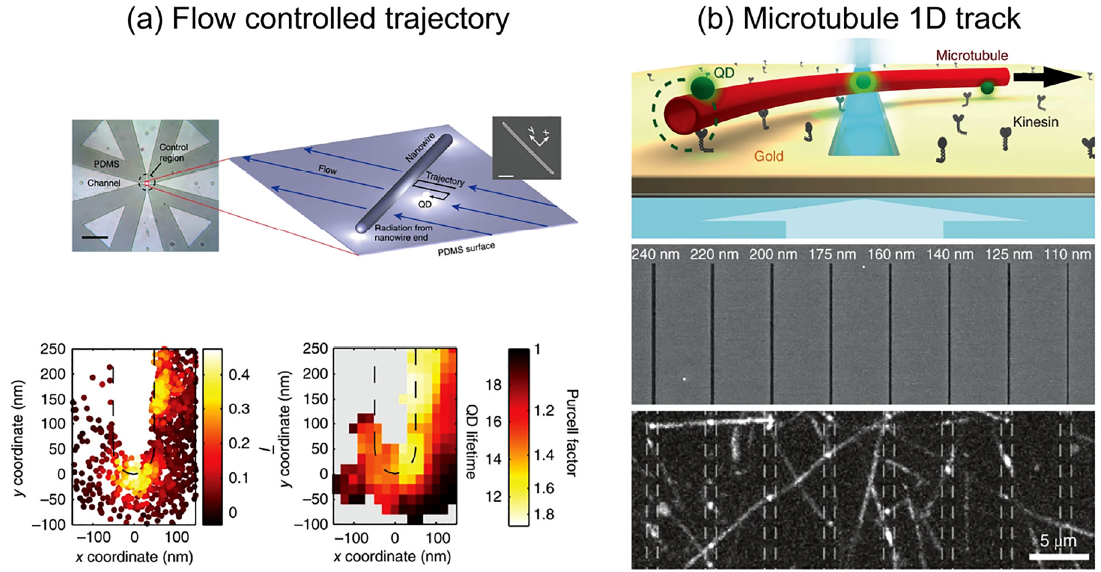
Figure 8: Strategies to improve super-resolution mapping of nanophotonic structures. They include microfluidic flow control (a) to controllably move quantum dots over a nanophotonic system, and (b) constraining sources to move over 1D tracks by attaching quantum dots to motor proteins that walk over microtubules. The method in (a) approaches the notion of a controllable scanning source, as envisioned originally in the NSOM community. The results [130] show mean fluorophore brightness ̄ I and the quantum dot decay rate as function of position next to a plasmonic nanowire (photons are collected from the nanowire ends). The approach of Groß et al. [129] leverages the fact that quantum dots constrained to 1D trajectories, defined by randomly deposited microtubules, can be accurately tracked. The sample in this work consisted of 1D slits in a metal film, illuminated from below and imaged from above. This method is mainly suited to measure the nanophotonic properties of translation invariant systems across 1D cross sections. Panels adapted from [129,